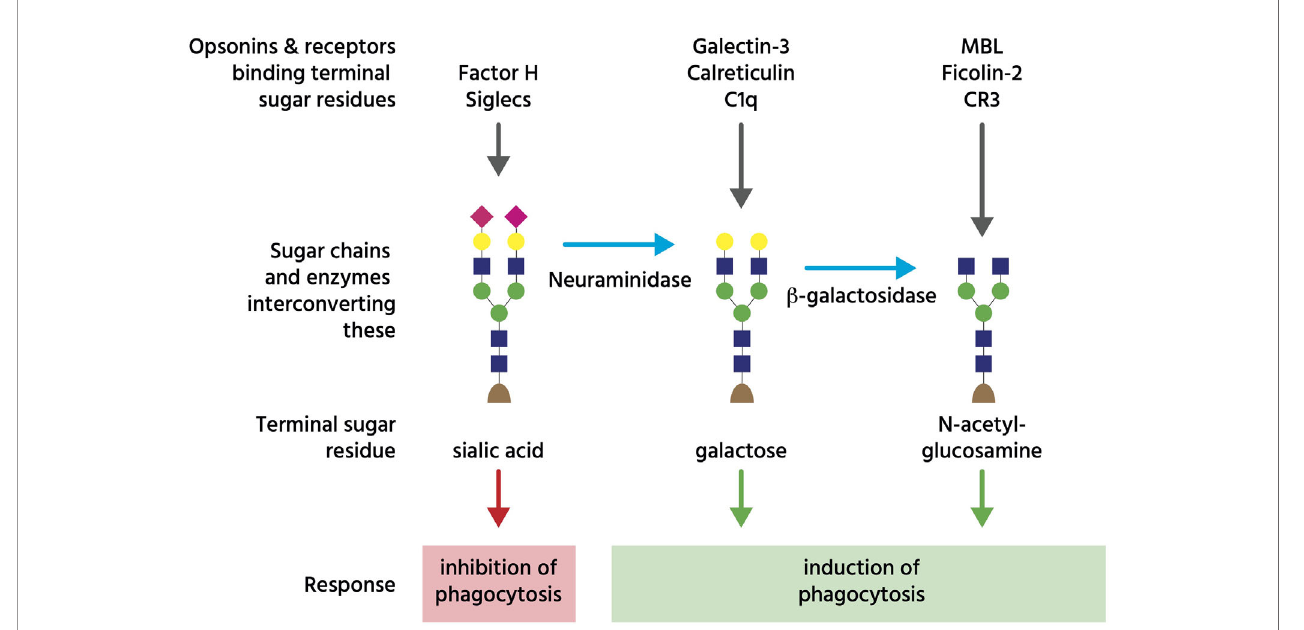
FIGURE 3 | Glycans regulating phagocytosis. The coloured shapes illustrate sugar residues in a typical glycan chain on an N-glycosylated cell-surface glycoprotein, where the terminal (monosaccharide) sugar is normally sialic acid (pink diamond), which can bind either Factor H to inhibit complement, or Siglec receptors to inhibit phagocytosis. However, neuraminidases can remove that terminal sialic acid residue to reveal galactose residues (yellow circle), which bind opsonins galectin-3, calreticulin and C1q. Subsequently, beta-galactosidase can remove terminal galactose residues to reveal N-acetyl-glucosamine residues (blue square), which bind opsonins (and complement regulators) MBL (mannan binding lectin) and fi colin-2, as well as complement receptor 3 (CR3). This fi gure is a considerable simpli fi cation of actual sugar chains and their regulation of